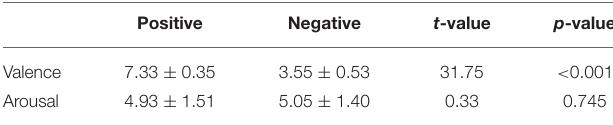
TABLE 1 | The mean ± standard deviation values for valence and arousal in each condition.